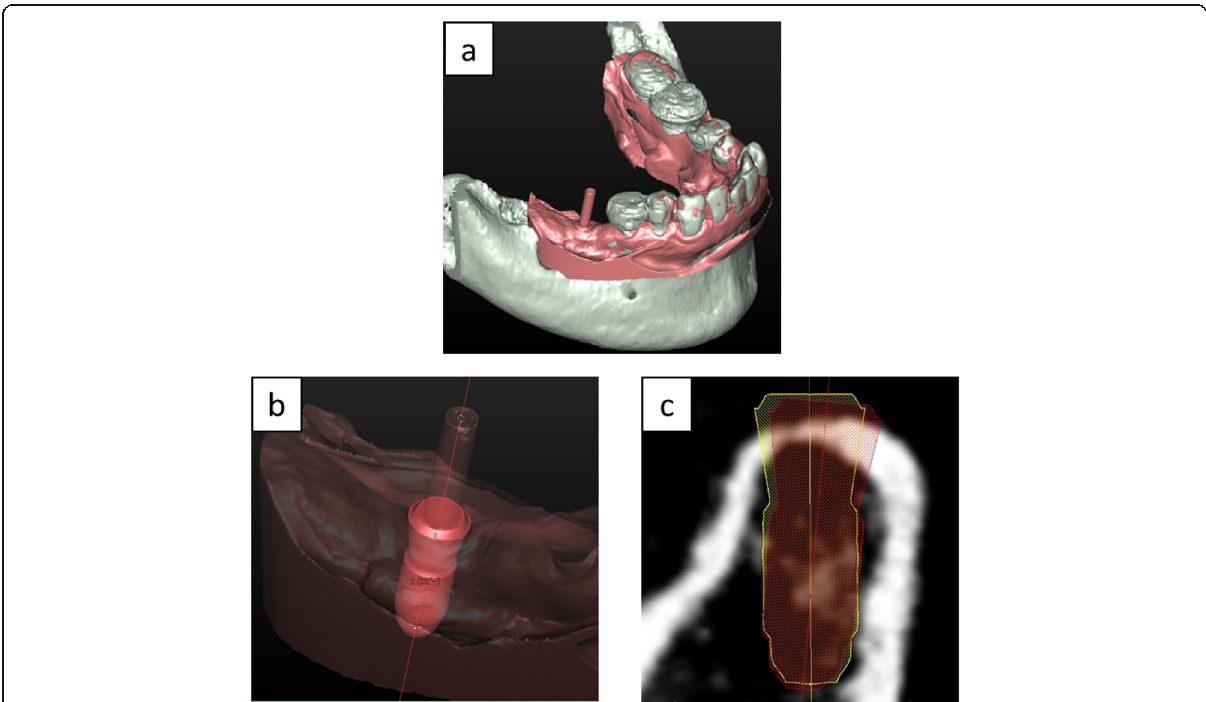
Fig. 2 Assessment of placed implant position. a Matching digital data between preoperative planned computed tomography image (gray- colored model) and scanned postoperative impression (pink-colored model). b Assessing placed implant position using implant collar and guide pin as references. c Comparing planned (yellow-colored) and placed (red-colored) implant position